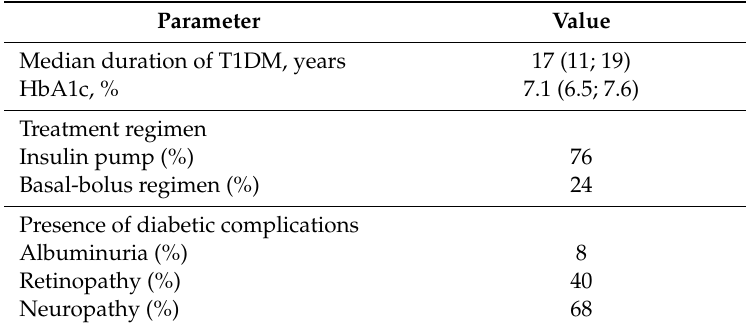
Table 2. Characteristics of the patients with type 1 diabetes mellitus (T1DM) in terms of the underlying disease.